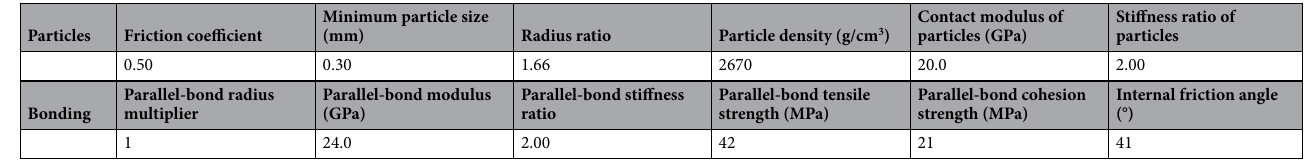
Table 1. Mesoscopic parameters of the marble.